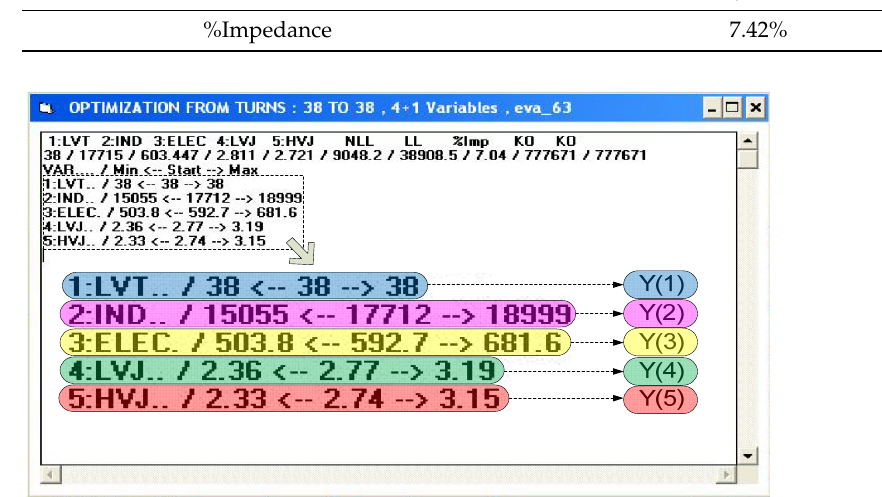
Figure 2. The calculation result for finding the suitable value.